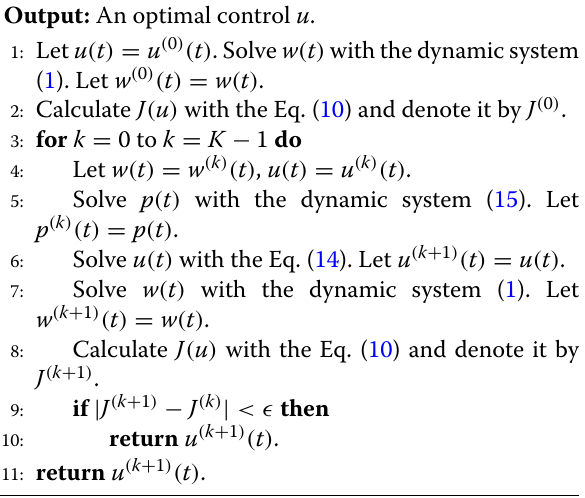
Algorithm 1 Optimal cloud assistance